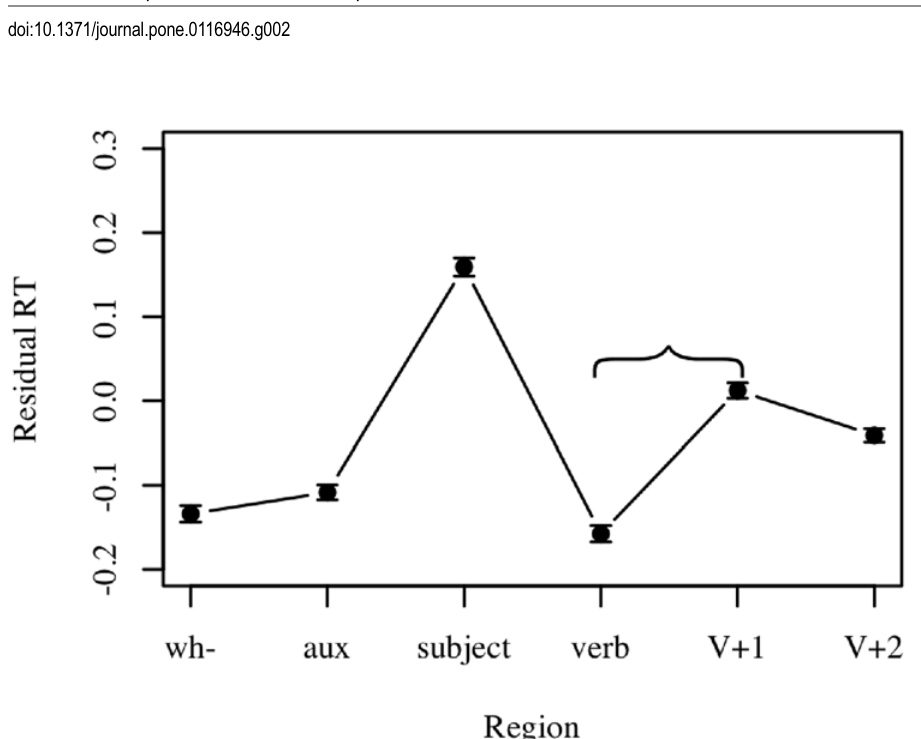
Fig 3. Filler-gap effect results. Mean residual reading time is plotted by region for all conditions in Experiment 1. The effect of interest is the difference between the verb region and the V+1 region. Error bars represent standard error of the mean.